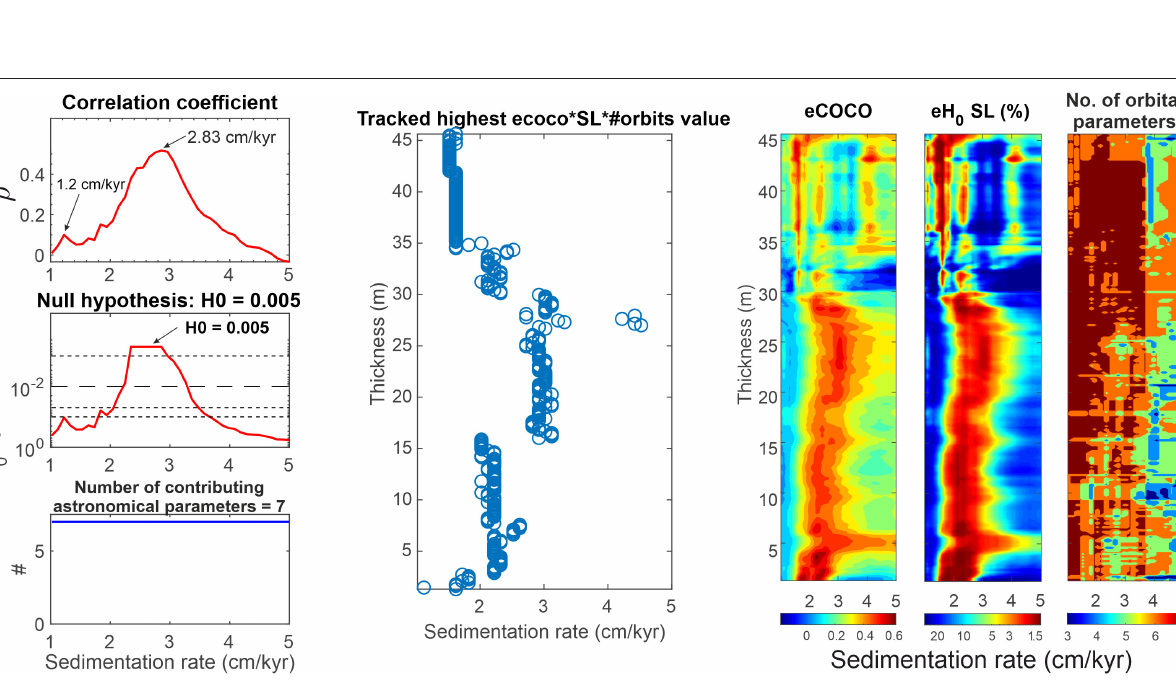
Frontiers in Earth Science |